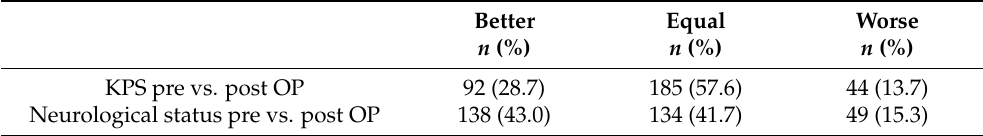
Table 6. Qualitative comparison between pre- and postoperative KPS, and between pre- and postop- erative neurological status. KPS = Karnofsky performance status scale, OP =